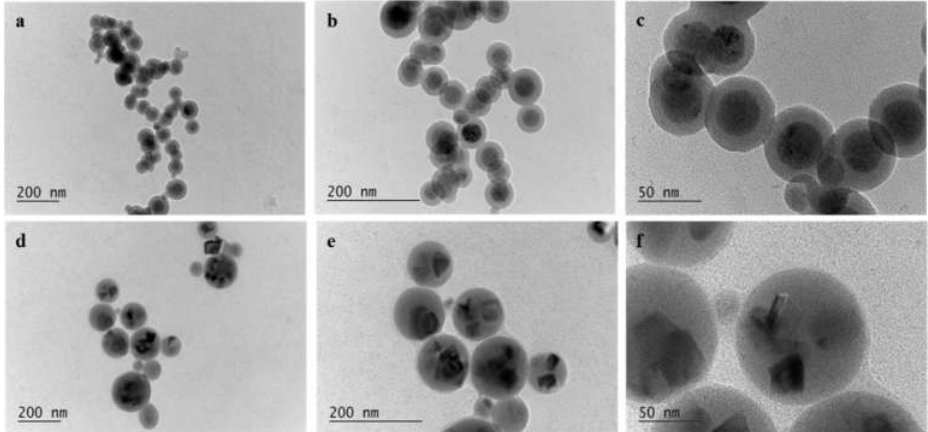
(20,000× ( a , d ), 40,000× ( b , e ), and 100,000× ( c , f )).